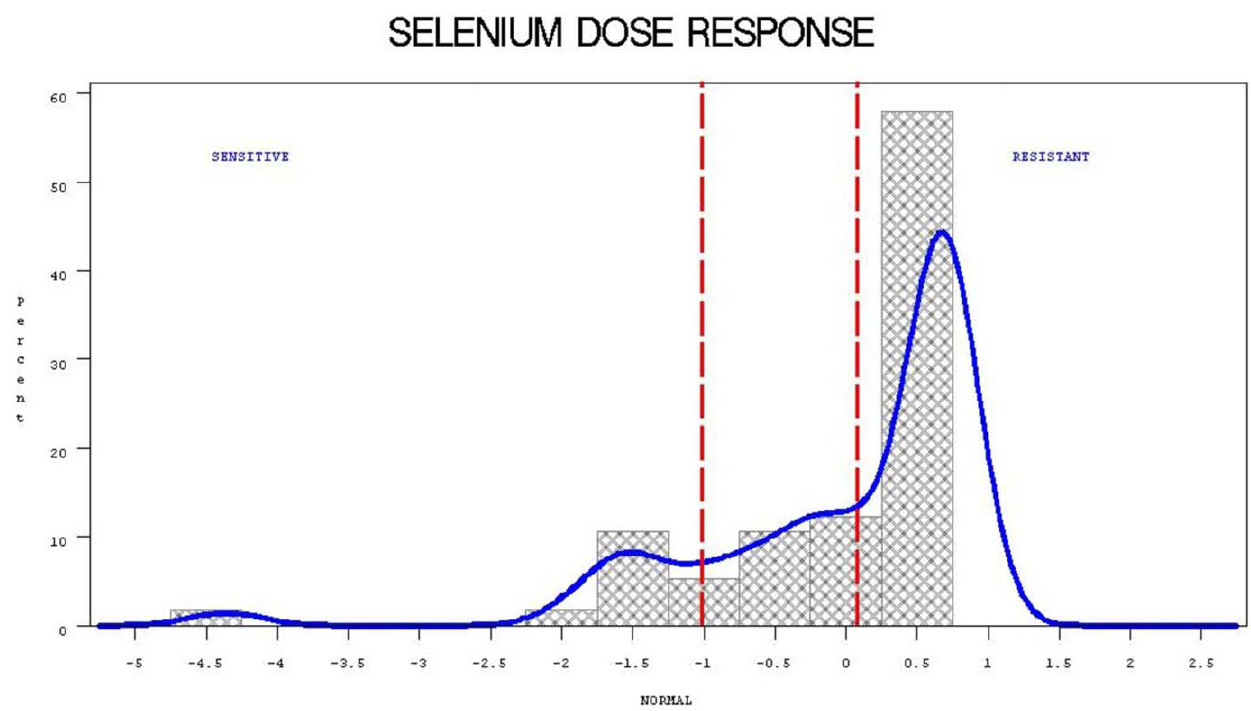
Figure 1. Distribution of NCI60 cell lines with respect to their response to Selenium treatment.